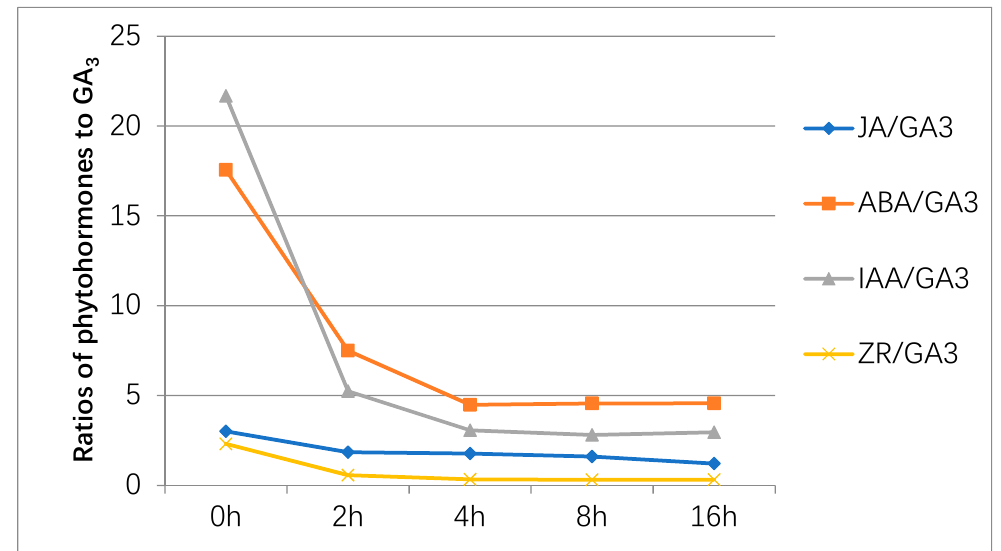
Figure 1. Changes of the ratios between four endogenous phytohormones contents to endogenous gibberellins contents with the exogenous GA 3 treatments for 0, 2, 4, 8, and 16 h.